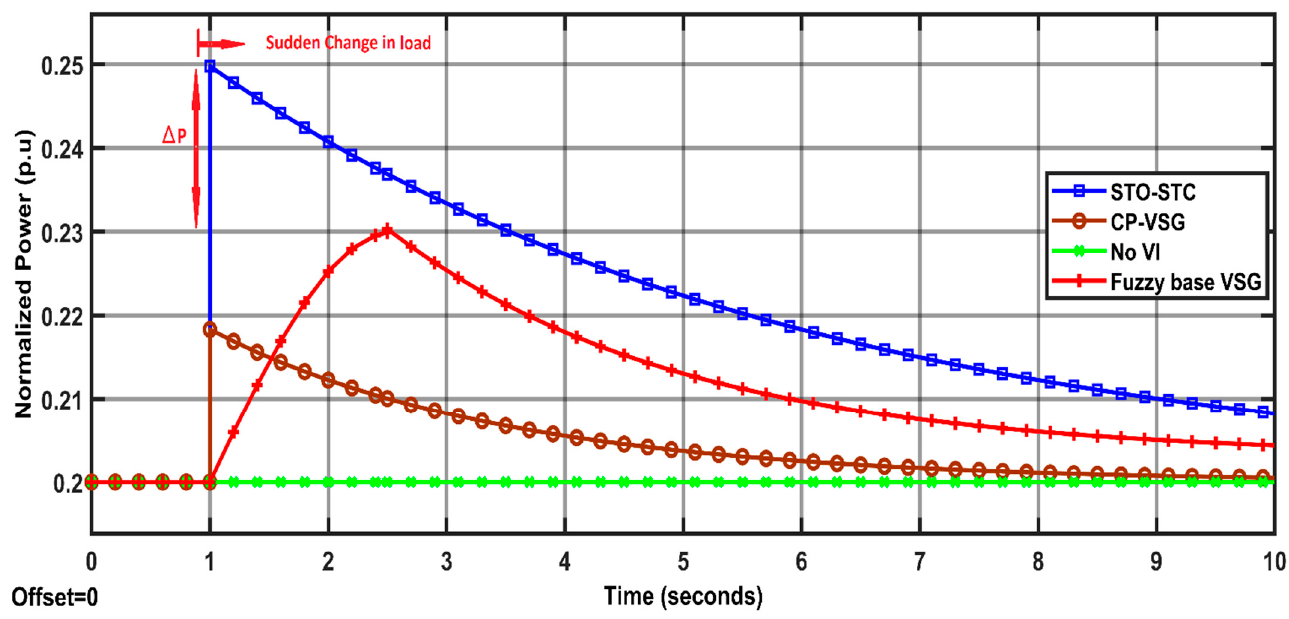
Figure 8. Performance evaluation and comparison of various schemes on injected normalized power during a sudden load change (pu).